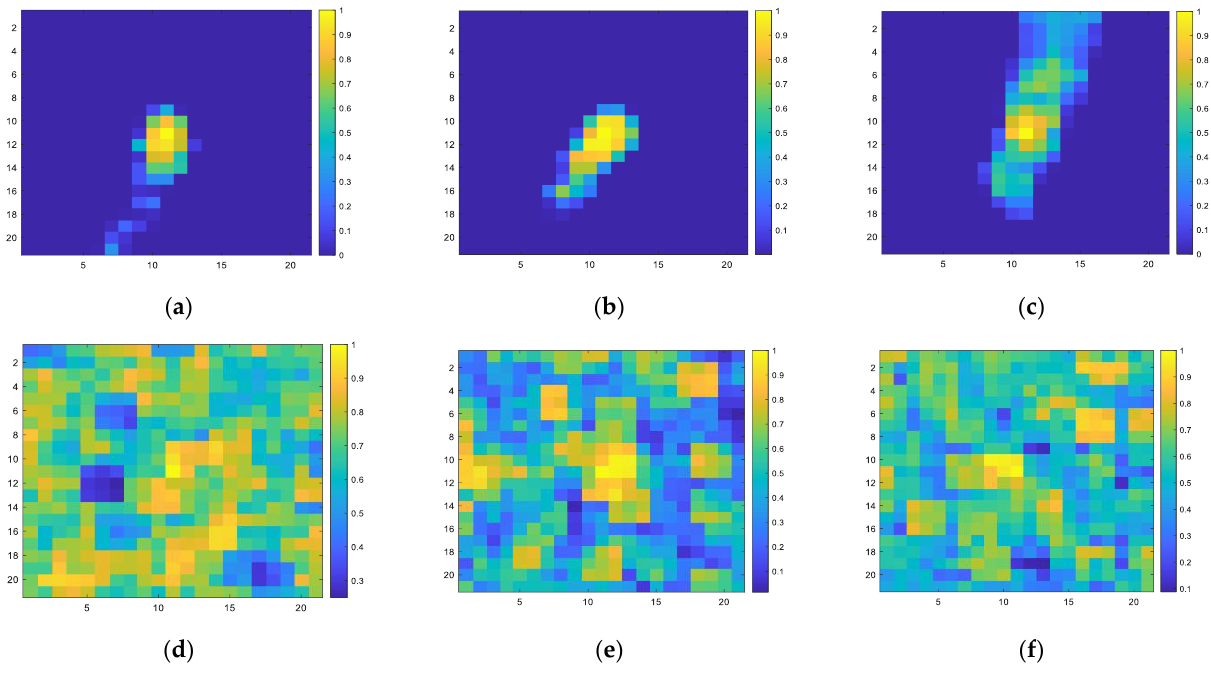
Table 2. P vi of the six pixels in Figure 5.